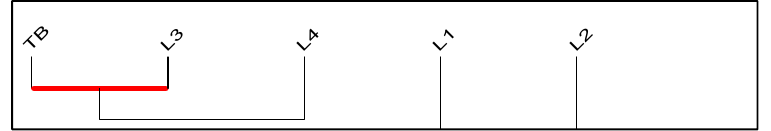
Figure 7. Similarity graph for variables, Type L (level of geometrical thinking of the students) and TB (the student marks all of the statements of task B correctly).